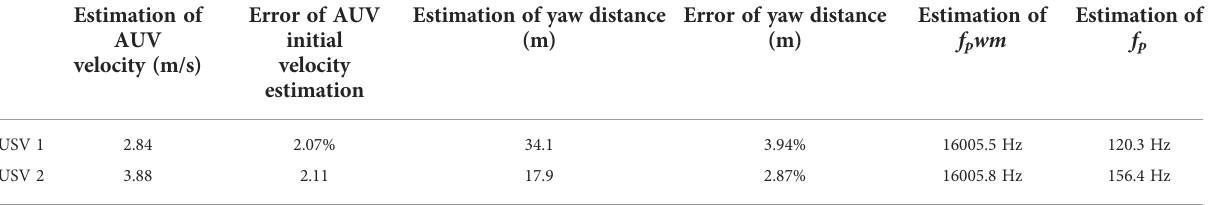
TABLE 3 Motion trajectory at multiple times after initial calculation